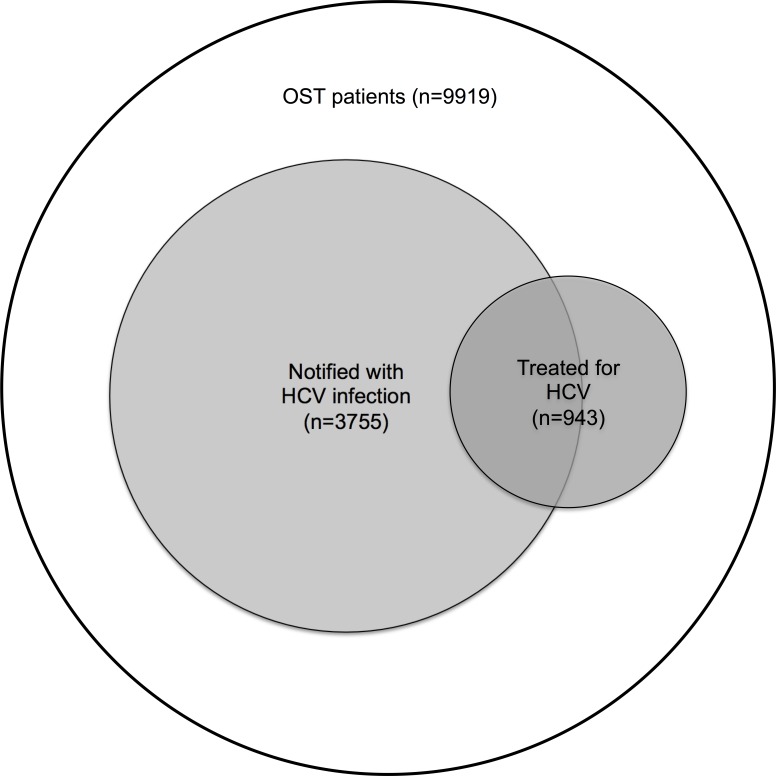
Venn diagram illustrating the relationship between all opioid substitution treatment (OST) patients (n = 9919), OST patients notified with hepatitis C virus (HCV) infection (study population; n = 3755) and all OST patients treated for HCV infection (n = 943).Of all OST patients, 38% were notified with HCV infection. Of all patients treated for HCV infection, 57% were notified with HCV infection.